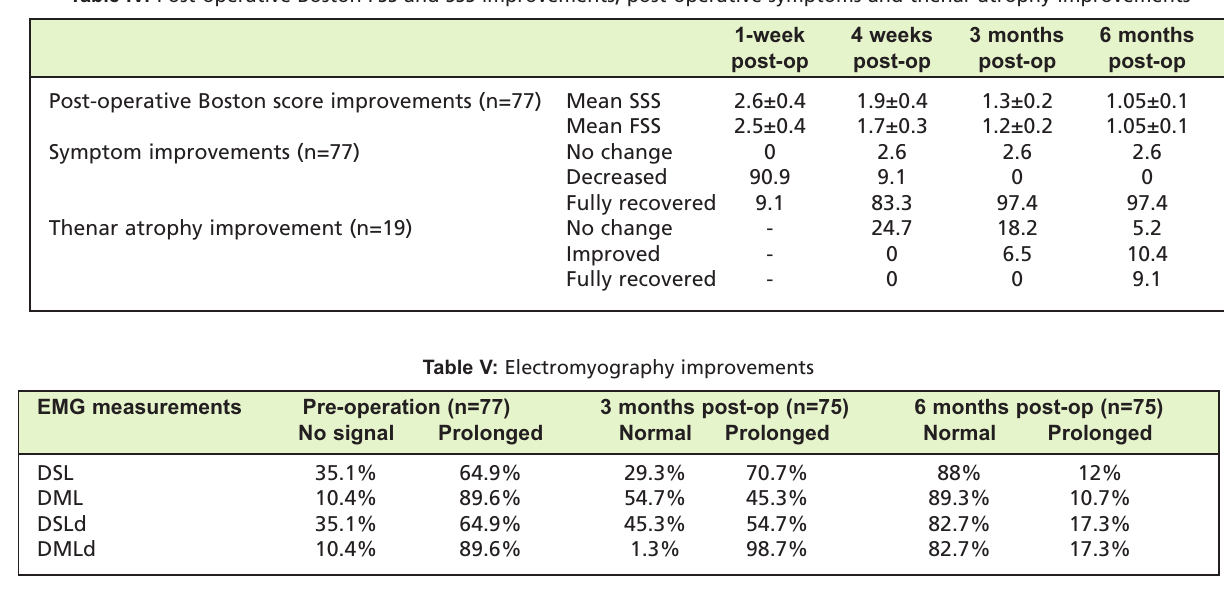
Post-operative Boston FSS and SSS improvements; post-operative symptoms and thenar atrophy improvements Table IV: